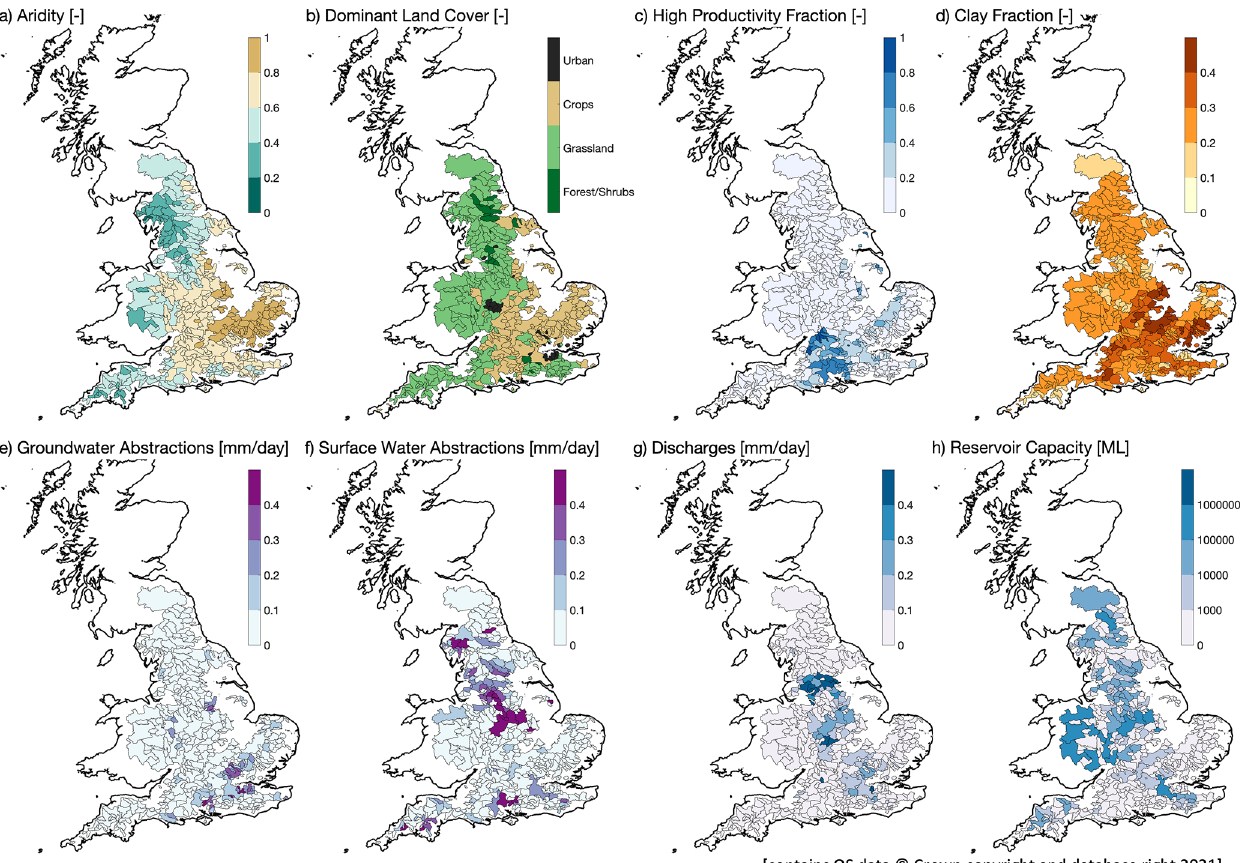
Figure 2. Selected catchment characteristics from CAMELS-GB.